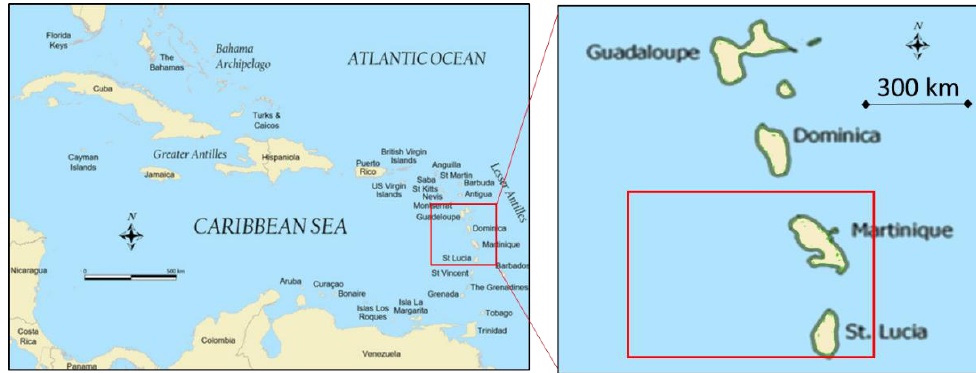
Figure 1. Study area (white box): The Antilles archipelago in the North Atlantic Ocean (13 – 17° N and 60 – 63° W) .